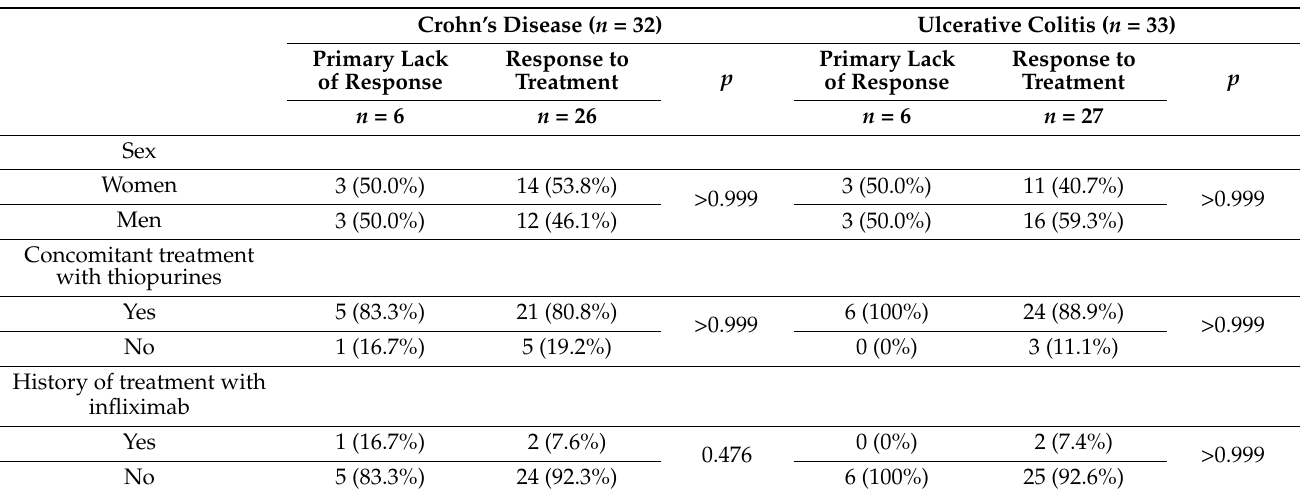
Table 4. Primary lack of